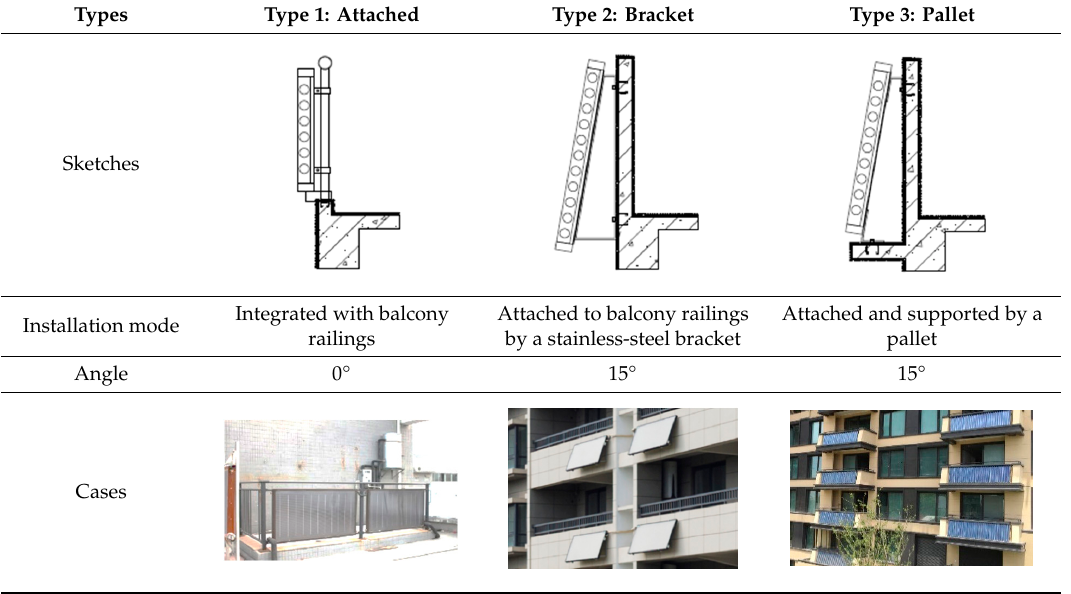
Table 6. Solar collector installation modes on balconies.